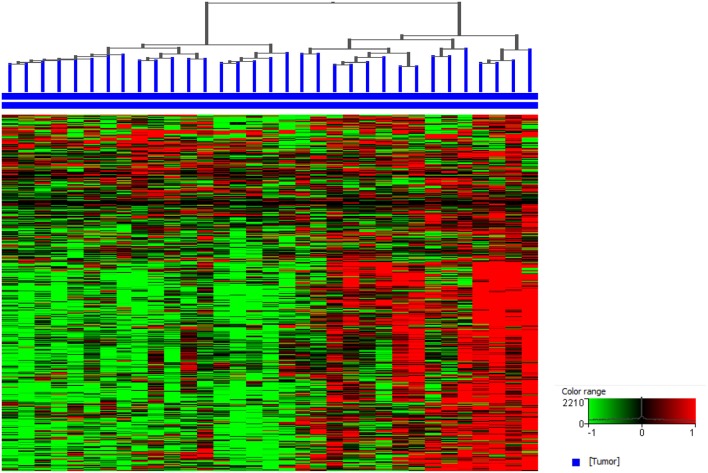
Canine invasive urothelial carcinoma (InvUC) samples display gene expression patterns classifying the tumors as immune infiltrated (immune “hot”) or non-immune infiltrated (immune “cold”). A list of immune signature genes known to be upregulated in T-cell inflamed human InvUC samples were used (170) to visualize the immune patterns that exist in canine InvUC. Normalized intensity values were used for supervised hierarchical clustering using Euclidean distance metrics and Ward's linkage algorithm as a distance metric. Note the predominantly high expression of immune genes in the right cluster of the canine InvUC samples (n = 15, 45%) classifying them as immune “hot” (immune infiltrated).